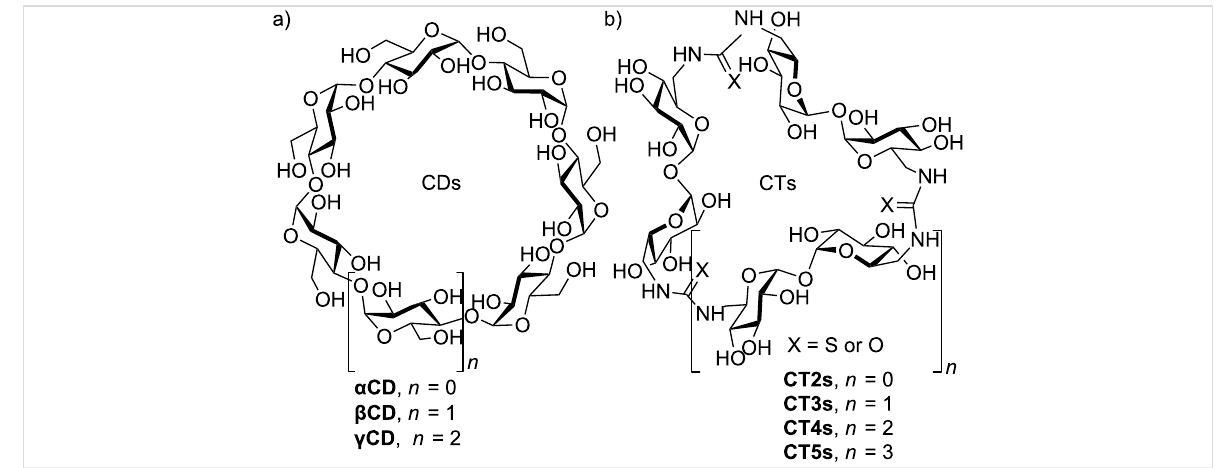
Figure 19: Schematic representation of (a) cyclodextrin (CDs) and (b) cyclotrehalan (CTs) family members.